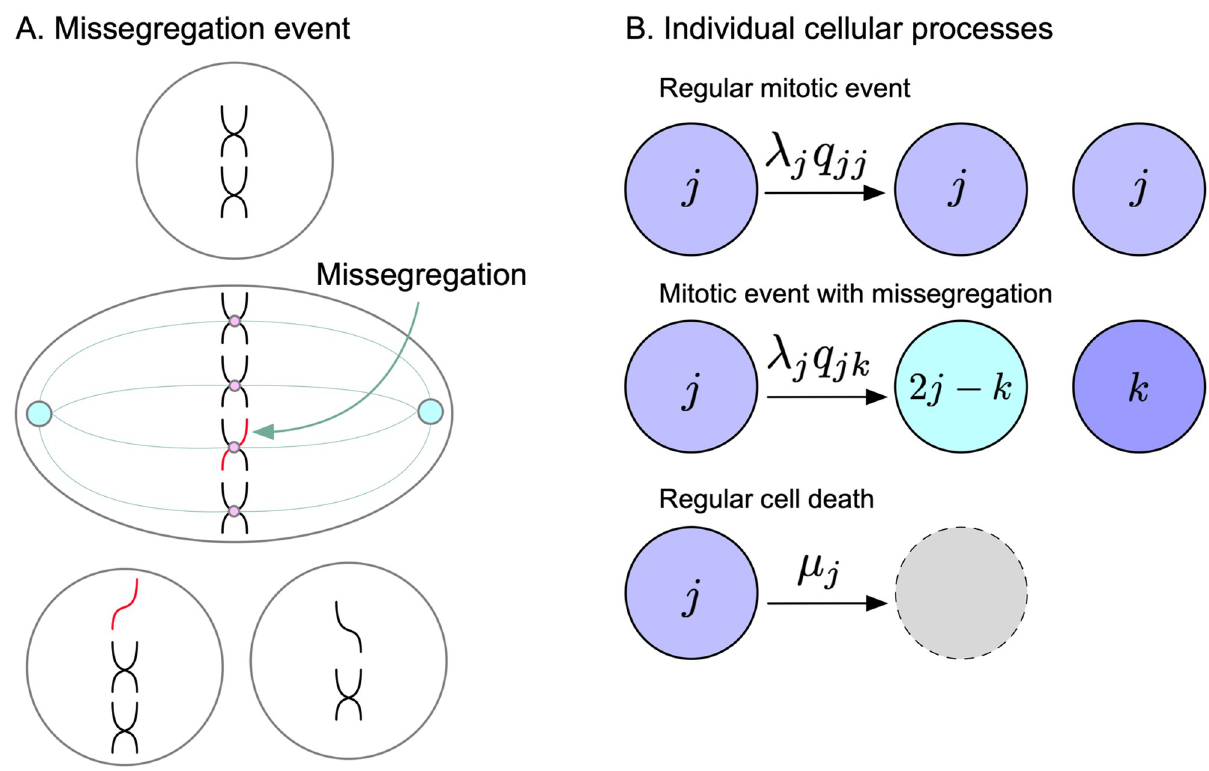
Fig 1. Mathematical modeling of chromosome missegregations. ( A ) Missegregation event. During anaphase, one daughter cell improperly takes both chromosomes leading to aneuploidy. Note the copy number conservation assumption here. ( B ) Model’s individual cellular processes. The tensor q jk encodes the probability at which a cell with copy number j may produce offspring with copy number k (and also 2 j − k by copy number conservation). Thus karyotype j goes through anaphase with faithful chromosome segregations at a rate λ j q jj and missegregates into karyotype k (and 2 j − k ) at a rate λ j q jk . Cell death occurs with rate μ j